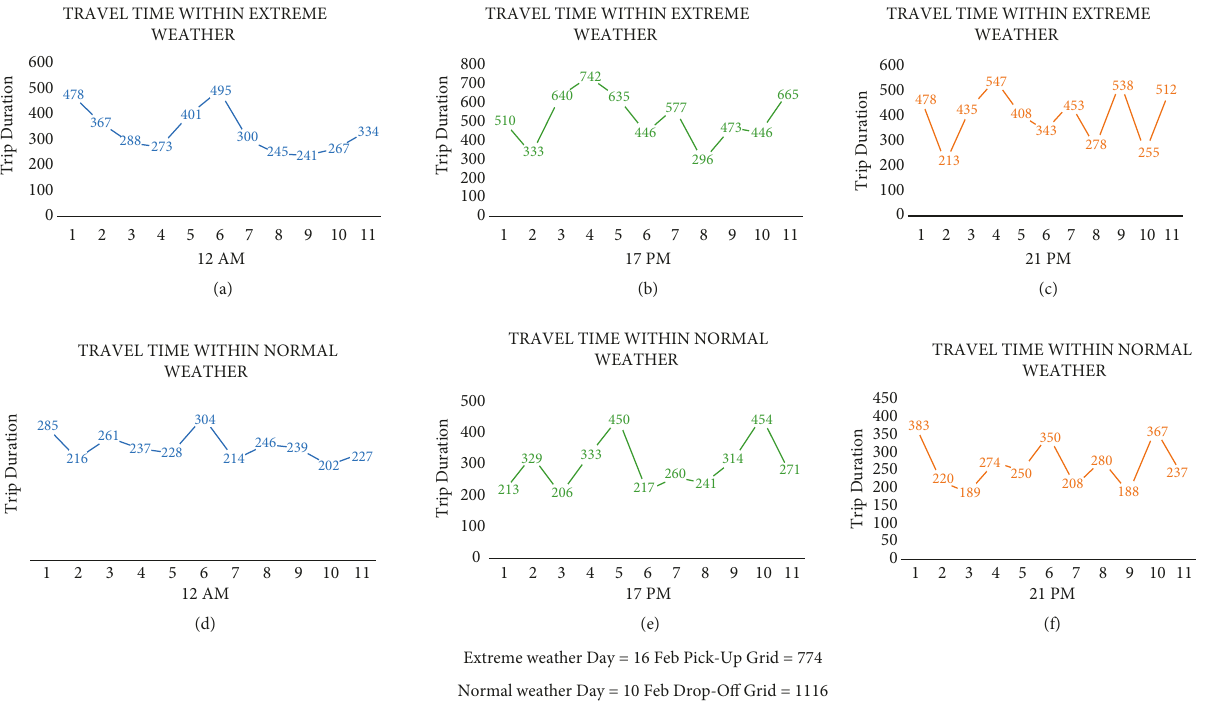
774 to drop-off grid- (cid:29)